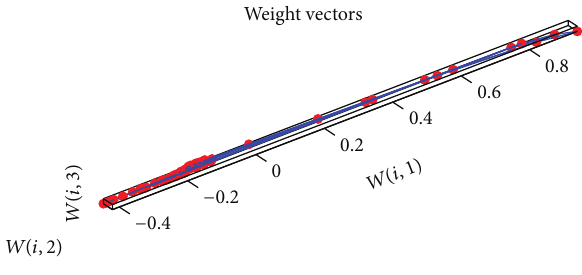
Figure 12: Training weights of SOM neural network.